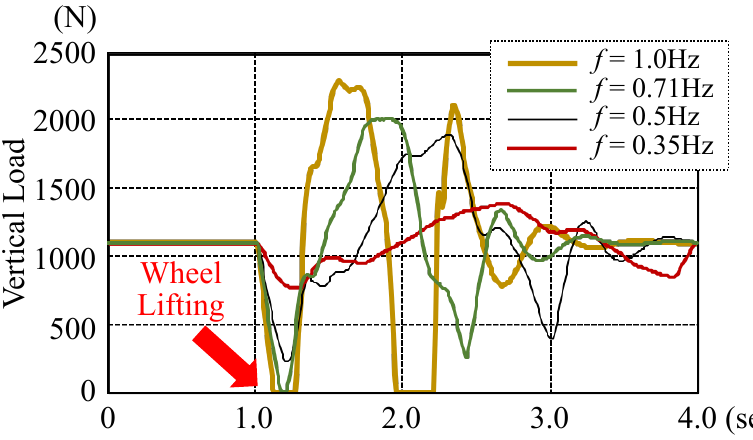
Figure 10. Quick steering input directly causes wheel lifting (I =